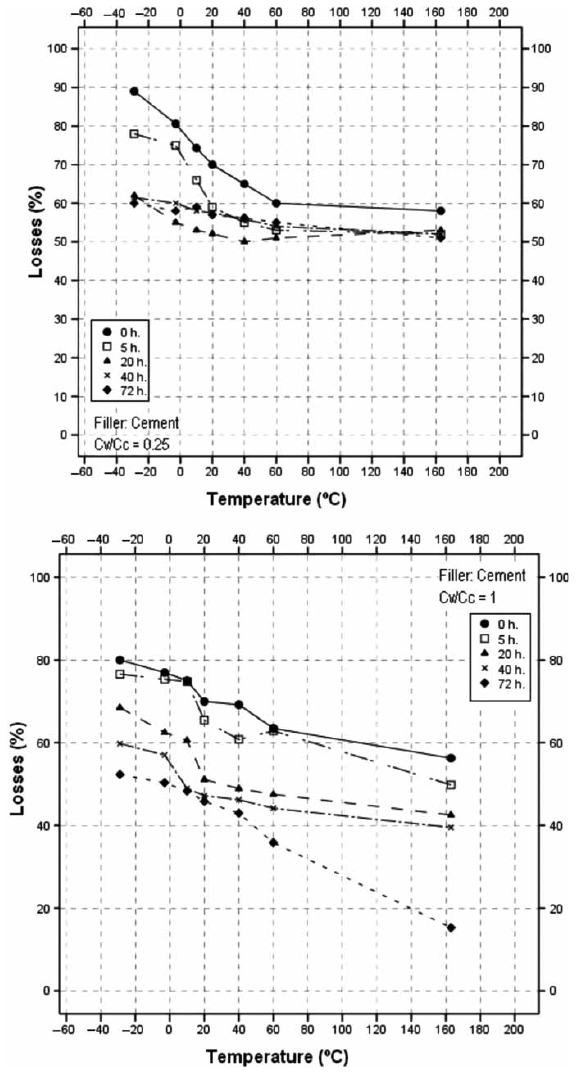
Fig. 2. Losses/temperature produced in samples with cement Fig. 3. State curves for mixtures made with calcium carbonate as